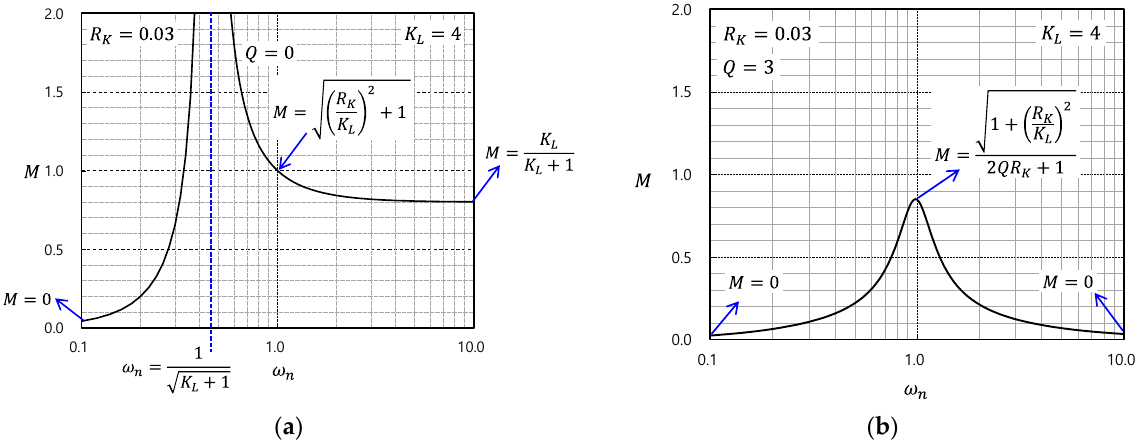
Figure 6. DC voltage gain M of LLC resonant converter according to each normalized frequency ω n : ( a ) When Q is 0; and ( b ) when Q is large.